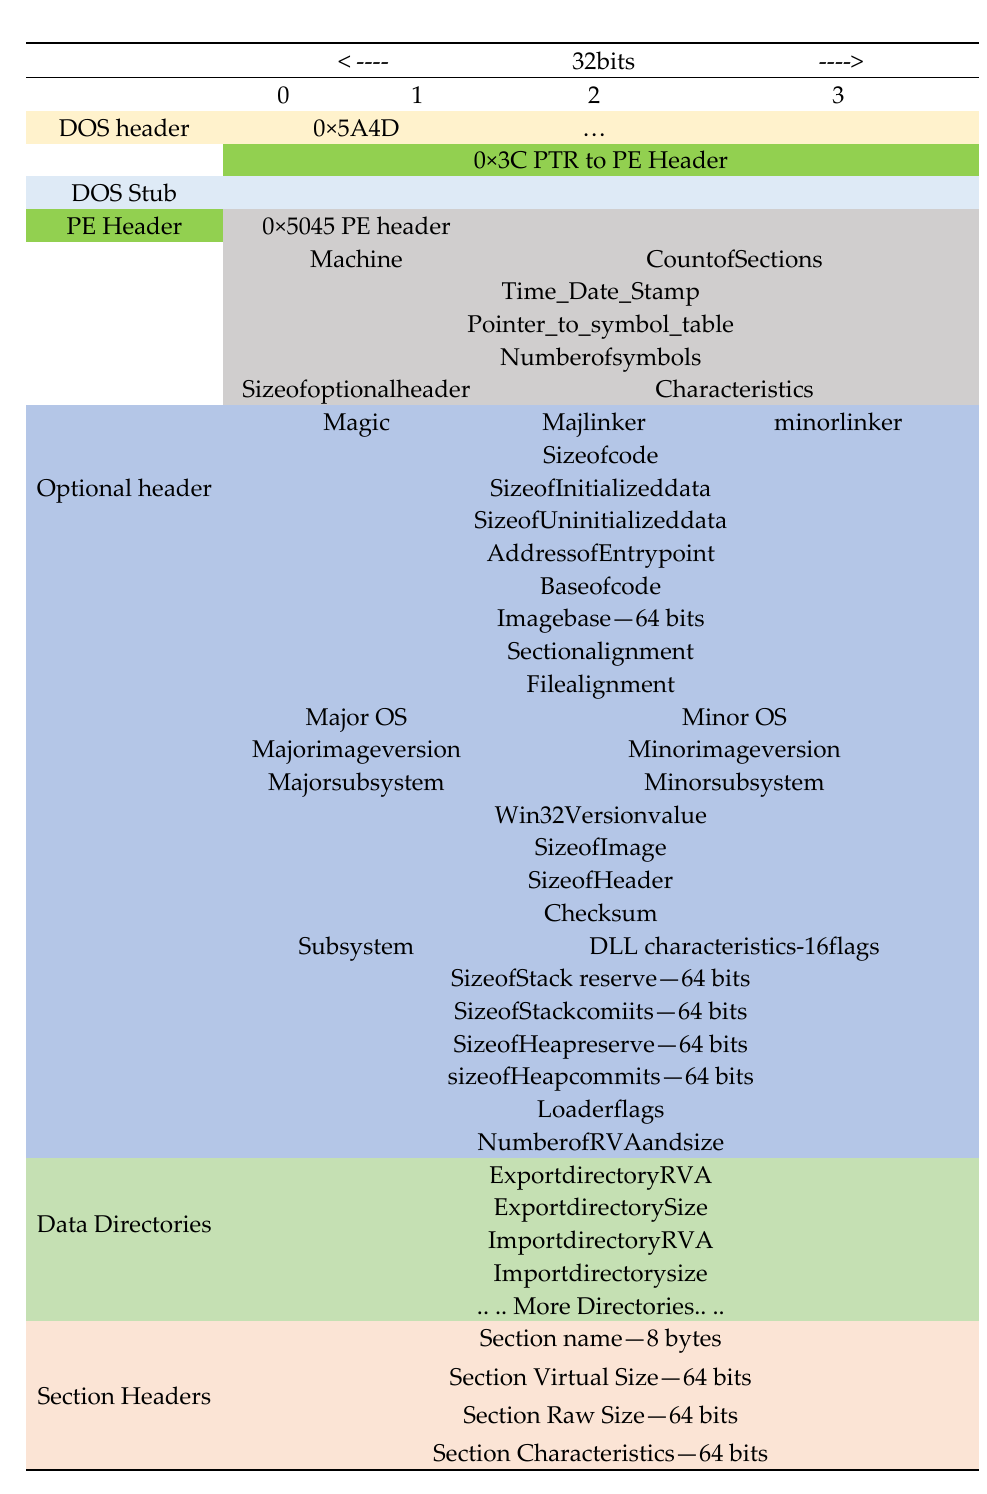
Figure 1. File header of a sample with details of components in the PE header.